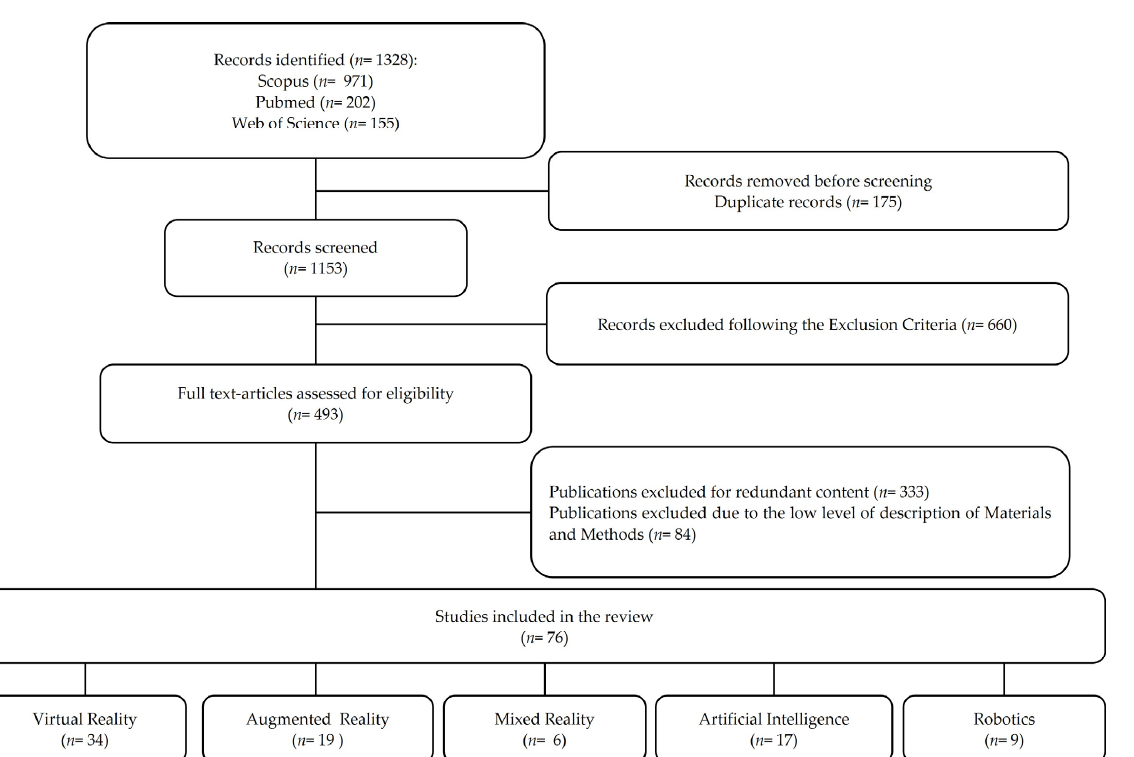
Figure 2. Flow chart of the literature selection process.